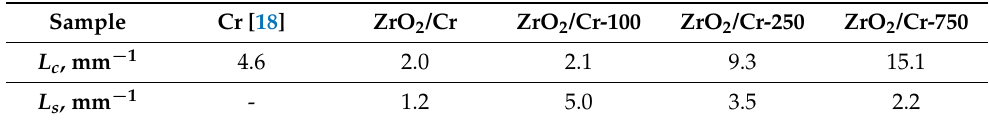
Table 2. The L c and L s parameters of the